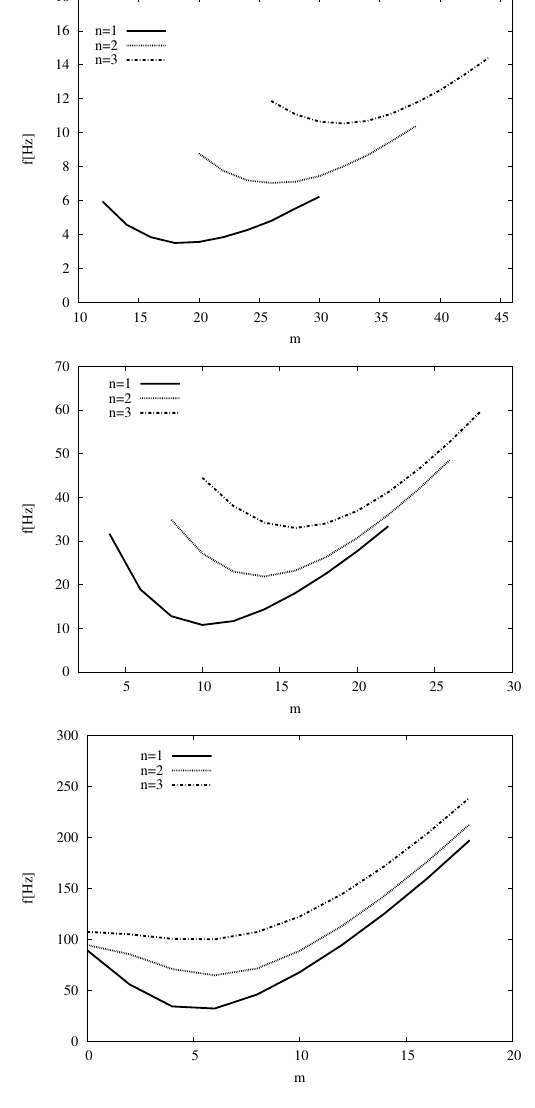
Figure 19: Fourth benchmark, simply supported cylinder embedding aluminium alloy and titanium alloy with thickness ratios R α /h=1000 (top), R α /h=100 (middle) and R α /h=10 (bottom). First (I) 3D fre- quencies versus half-wave numbers m (values around that for mini- mum frequency) and n (from 1 to 3).